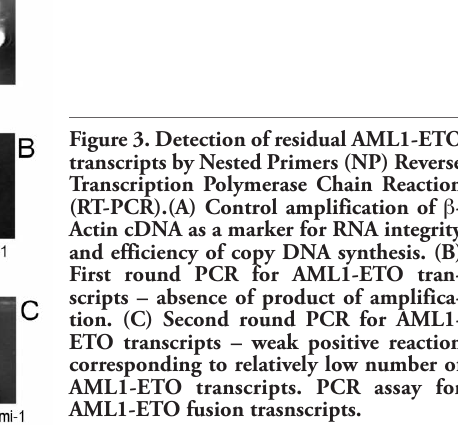
Figure 3. Detection of residual AML1-ETO transcripts by Nested Primers (NP)